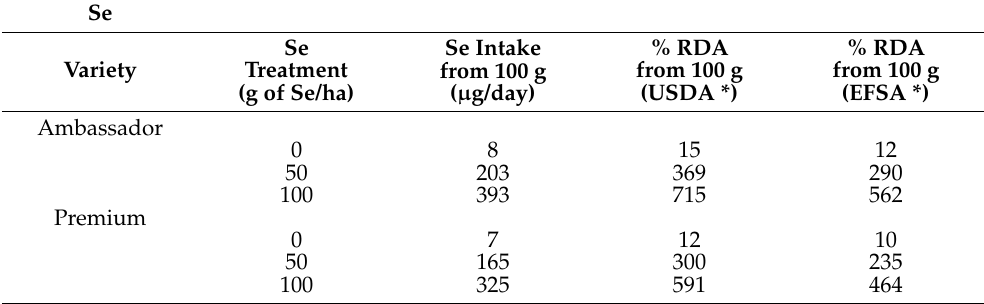
Table 3. Selenium/Zn intake and fraction (%) of recommended dietary allowance for Se/Zn (% RDA) obtained from 100 g of pea